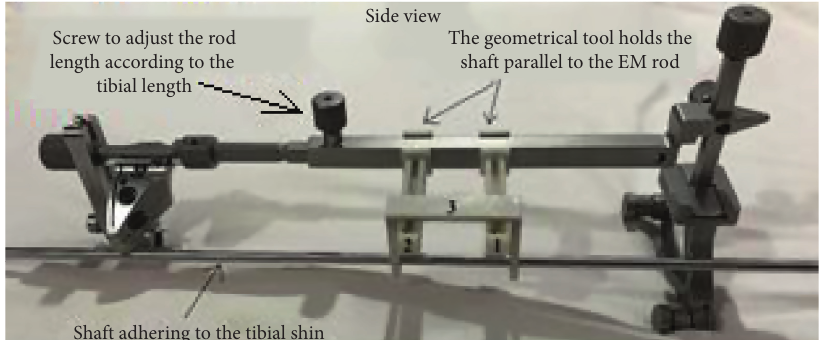
Figure 7: The geometrical tool (numbered 1, 2, and 3) fixed to the original tool.